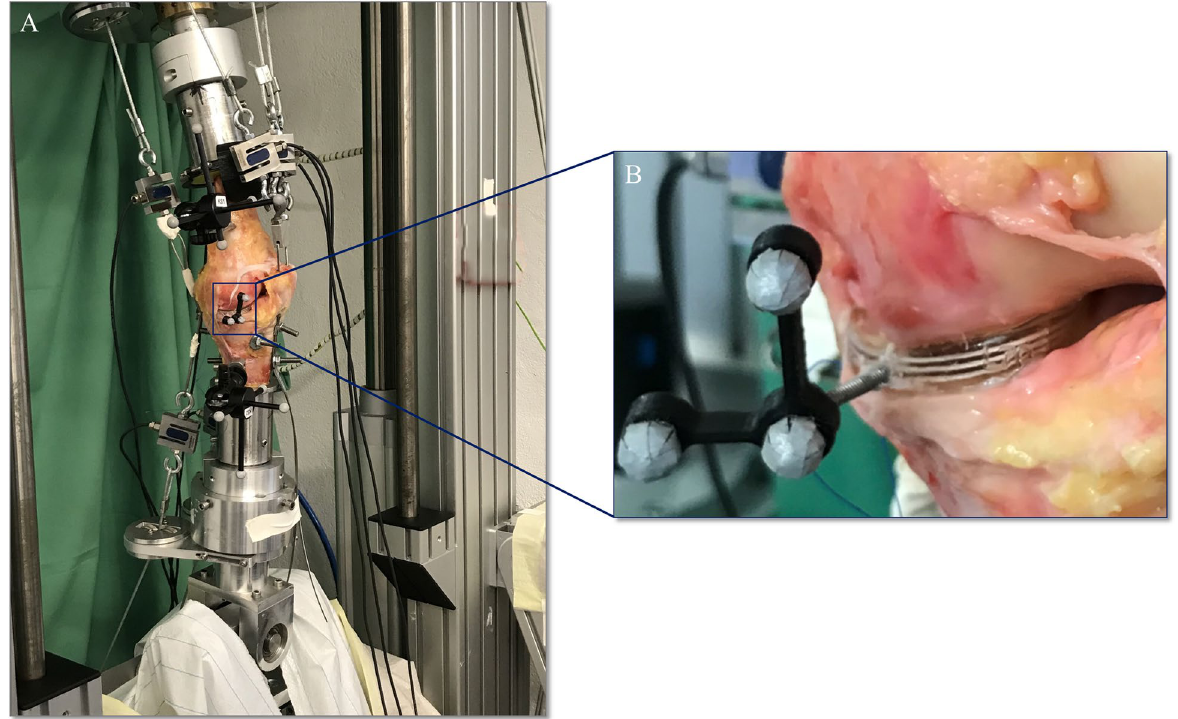
Fig. 2 A Dynamic knee simulator with embedded specimen, muscle simulation via steel cables and passive reflective rigid marker bodies at the femur, tibia and device. B View at the meniscus replacement device, inserted in the medial joint compartment and an attached passive reflective rigid marker body that allows for motion